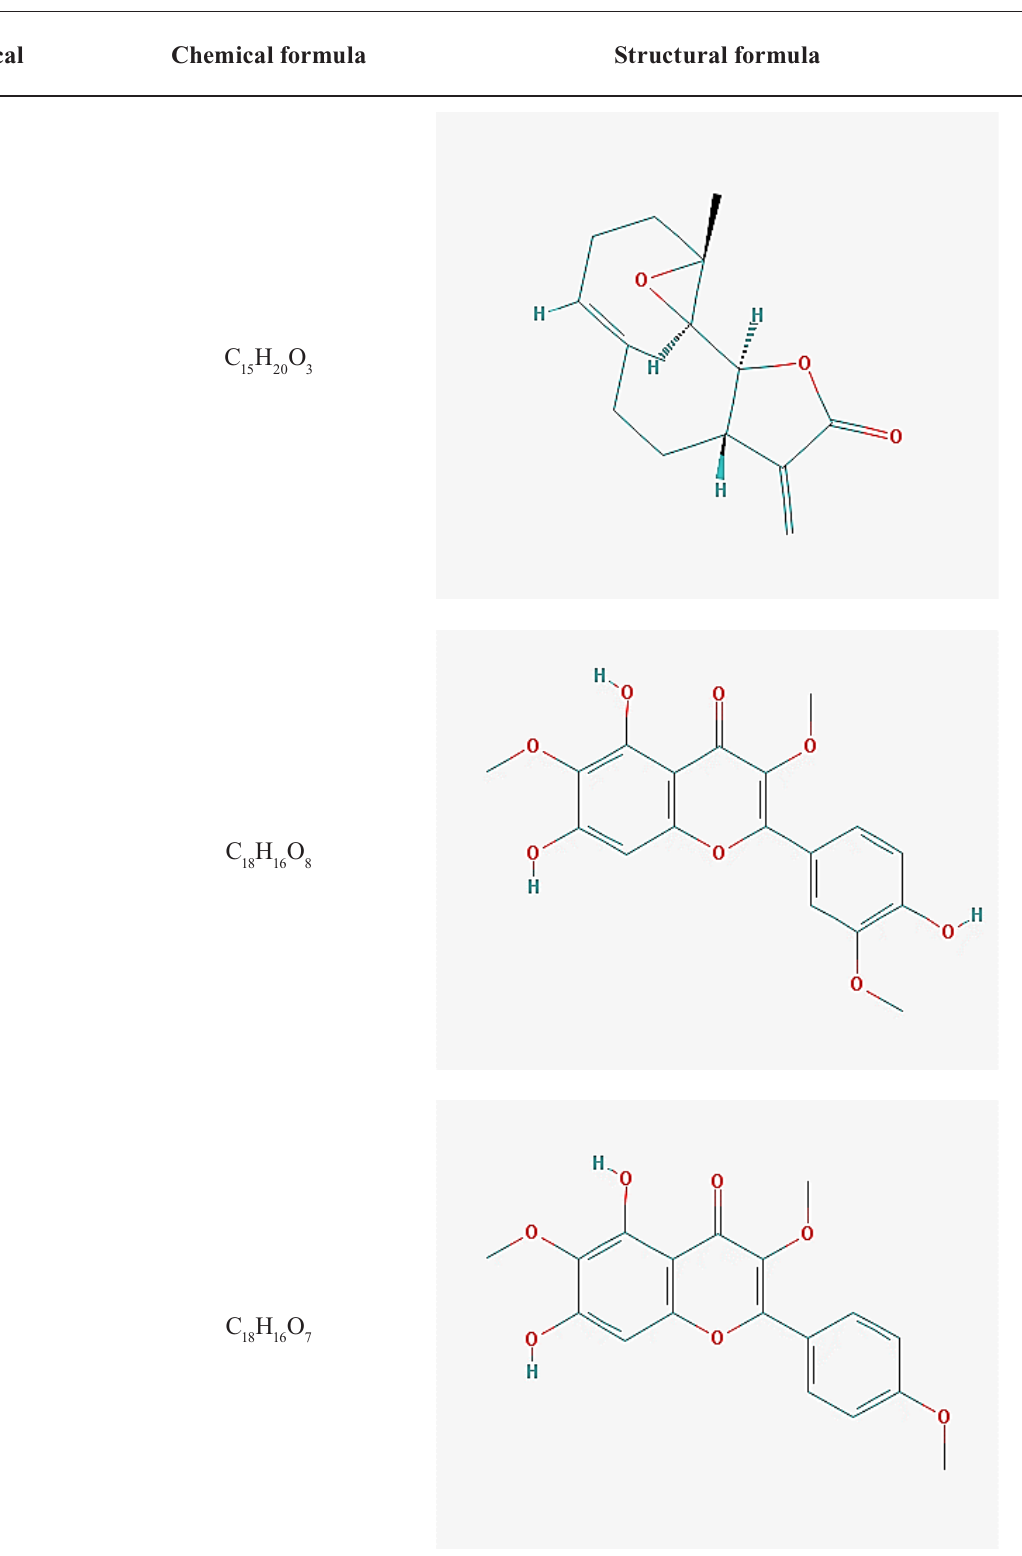
TABLE I - P hytochemicals from Tanacetum parthenium and Silybum